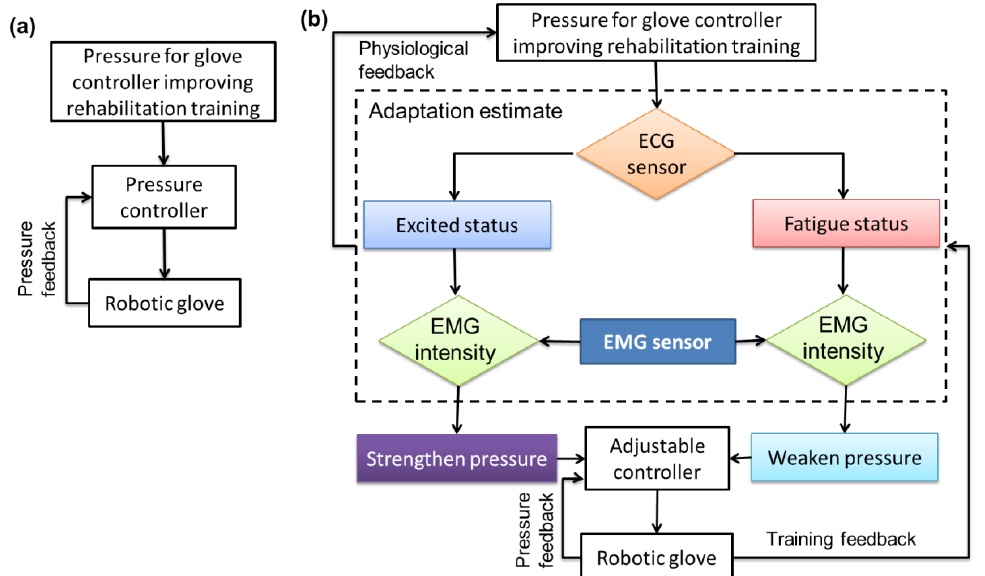
Figure 11. Robotic glove pressure adjusting for rehabilitation training ( a ) without and ( b ) with an adaptive control strategy.